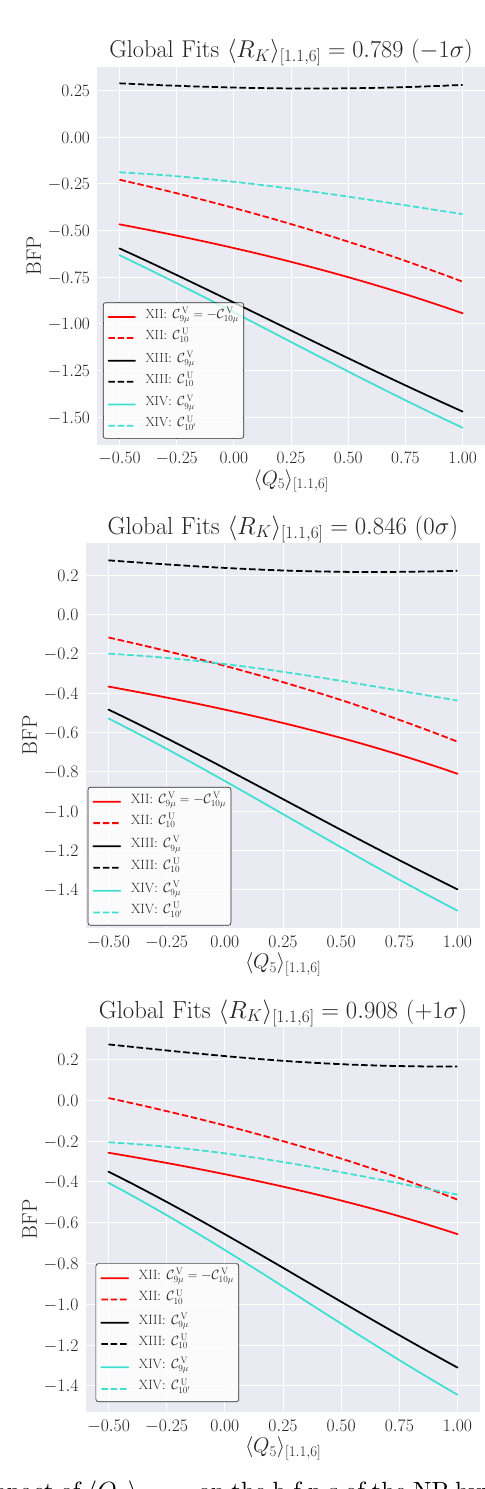
Figure 16. Global fit: impact of for different values of